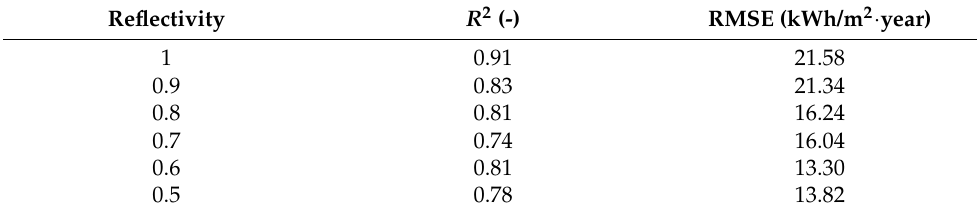
Table 9. Performance of the model of the potential maps of RC energy for different solar reflectiv- ity